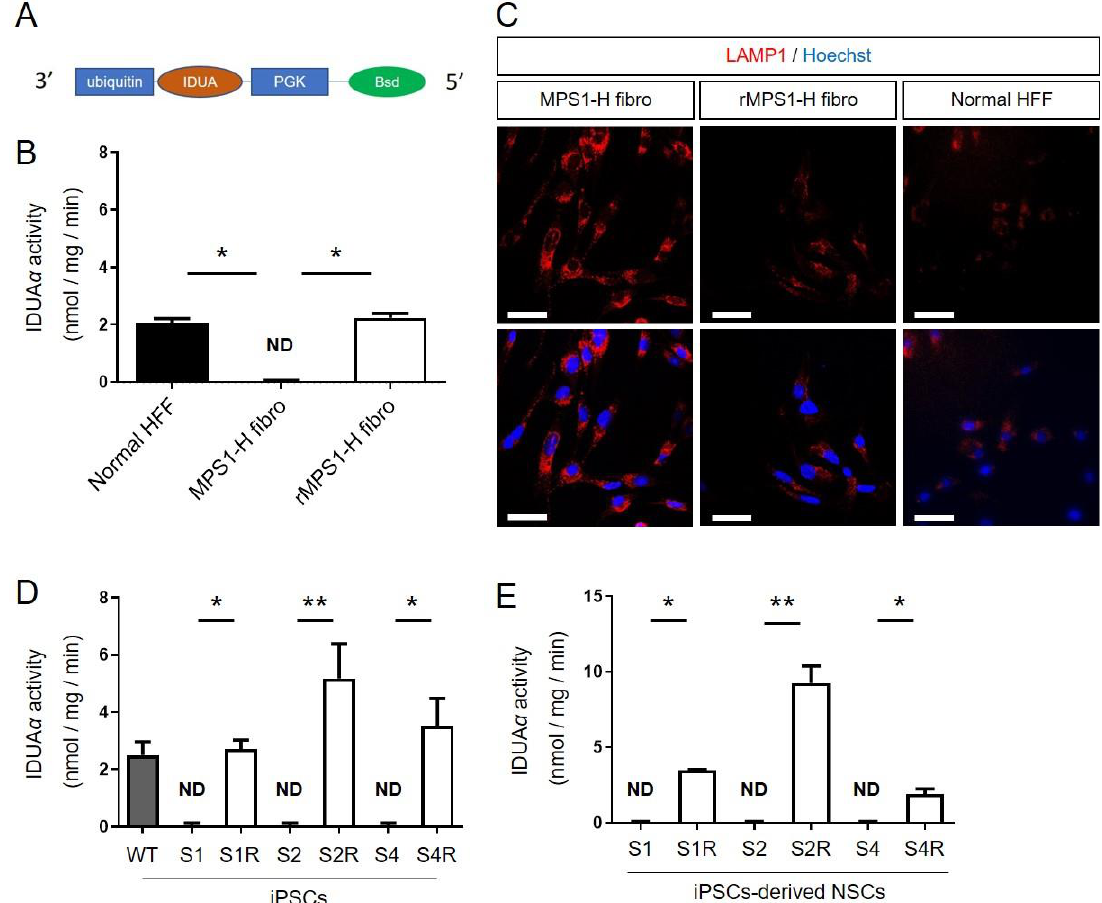
Figure 1. Validation of IDUA rescuing lentivector. ( A ) Schematic representation of the lentiviral vector. ( B ) Iduronidase activity (IDUA α ) and ( C ) LAMP1 expression in MPS1-H fibroblasts, MPS1-H rescued fibroblasts and normal human forskin fibroblasts (HFF). ( D ) Iduronidase activity (IDUA α ) in the three MPS1-H (S1–S4) and rMPS1-H iPSCs and ( E ) iPSCs-derived NSCs clones (S1R–S4R). Data are shown as mean ± SEM and were analyzed by independent samples t -test. * p < 0.05; ** p < 0.01.